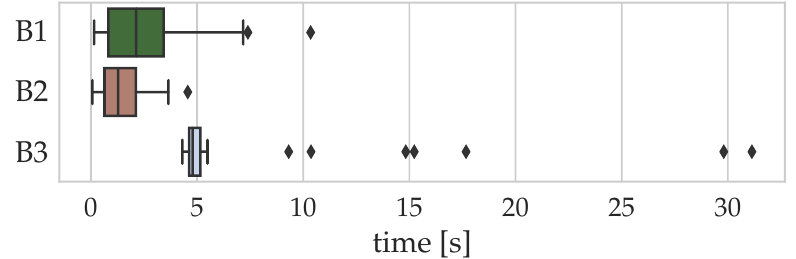
Figure 11. Boxplots of the calculation time of 50 runs of each Algorithm B